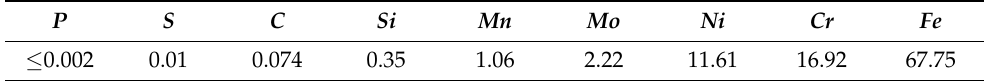
Table 1. Chemical composition of 316 stainless steel (wt.%) [39].